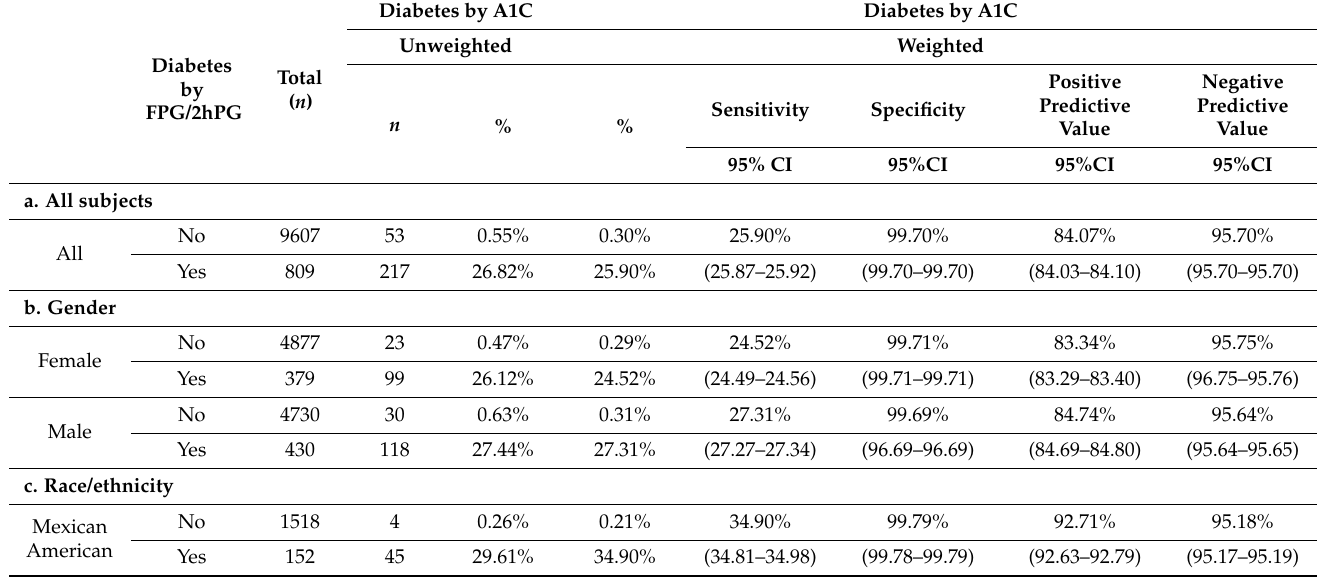
Table 2. Comparison of the performance of the A1C ≥ 6.5% criterion to the fasting and 2-h postchallenged glucose criteria with subgroup analyses in subjects without a prior diagnosis of